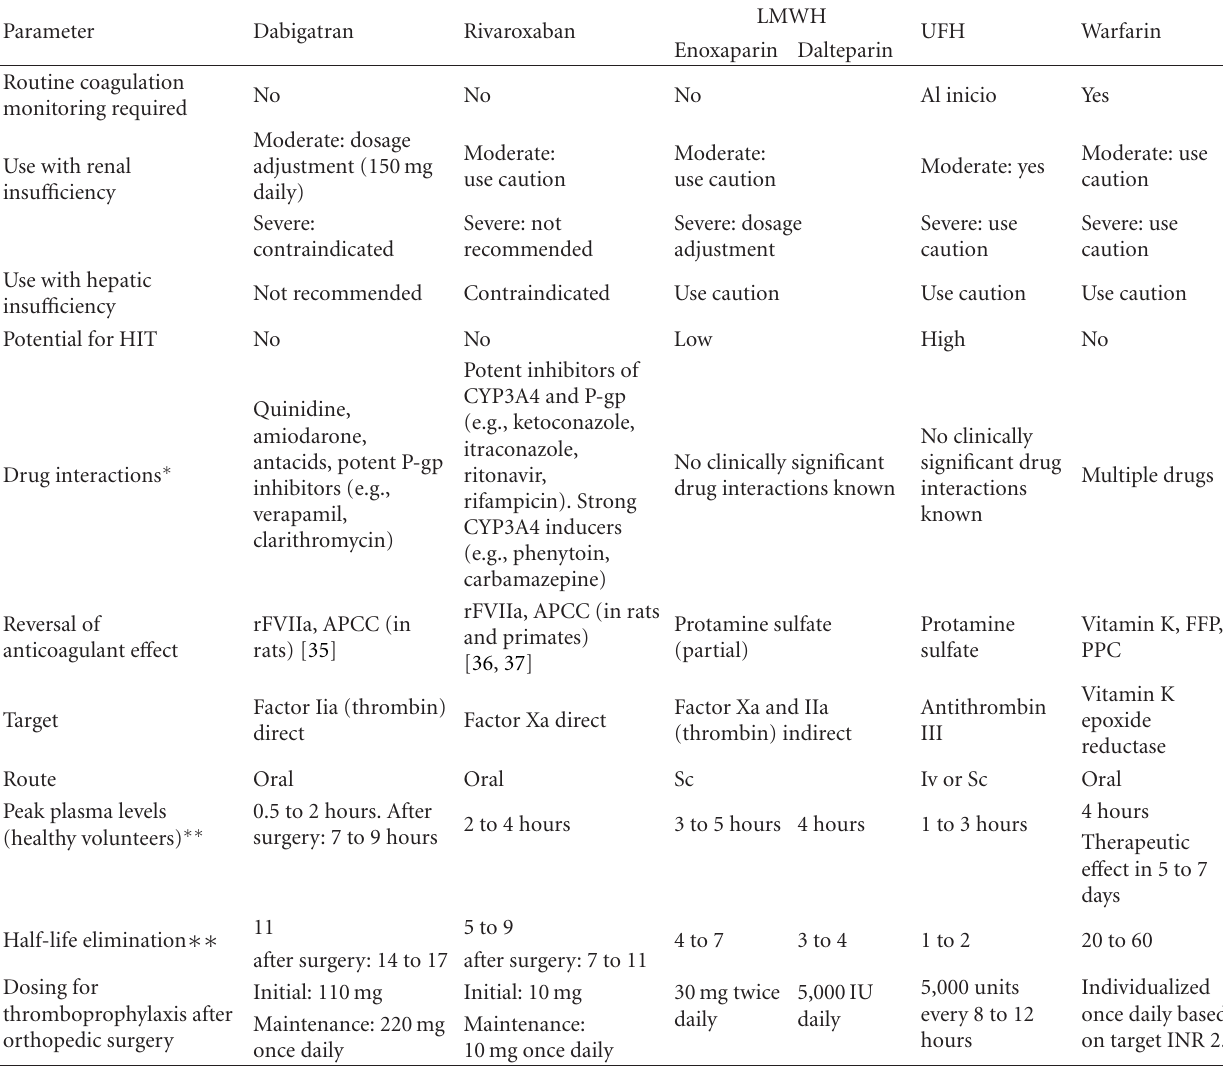
Table 5: Comparison of anticoagulants. APPC: activated prothrombin complex concentrate; CYP3A4: cytochrome P450 enzyme 3A4; FFP: fresh frozen plasma; HIT: heparin-induced thrombocytopenia; Iv: intravenous; IU: international units; LMWH: